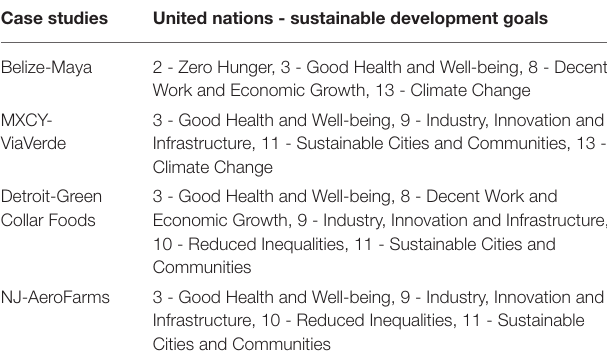
TABLE 1 | Sustainable development goals in